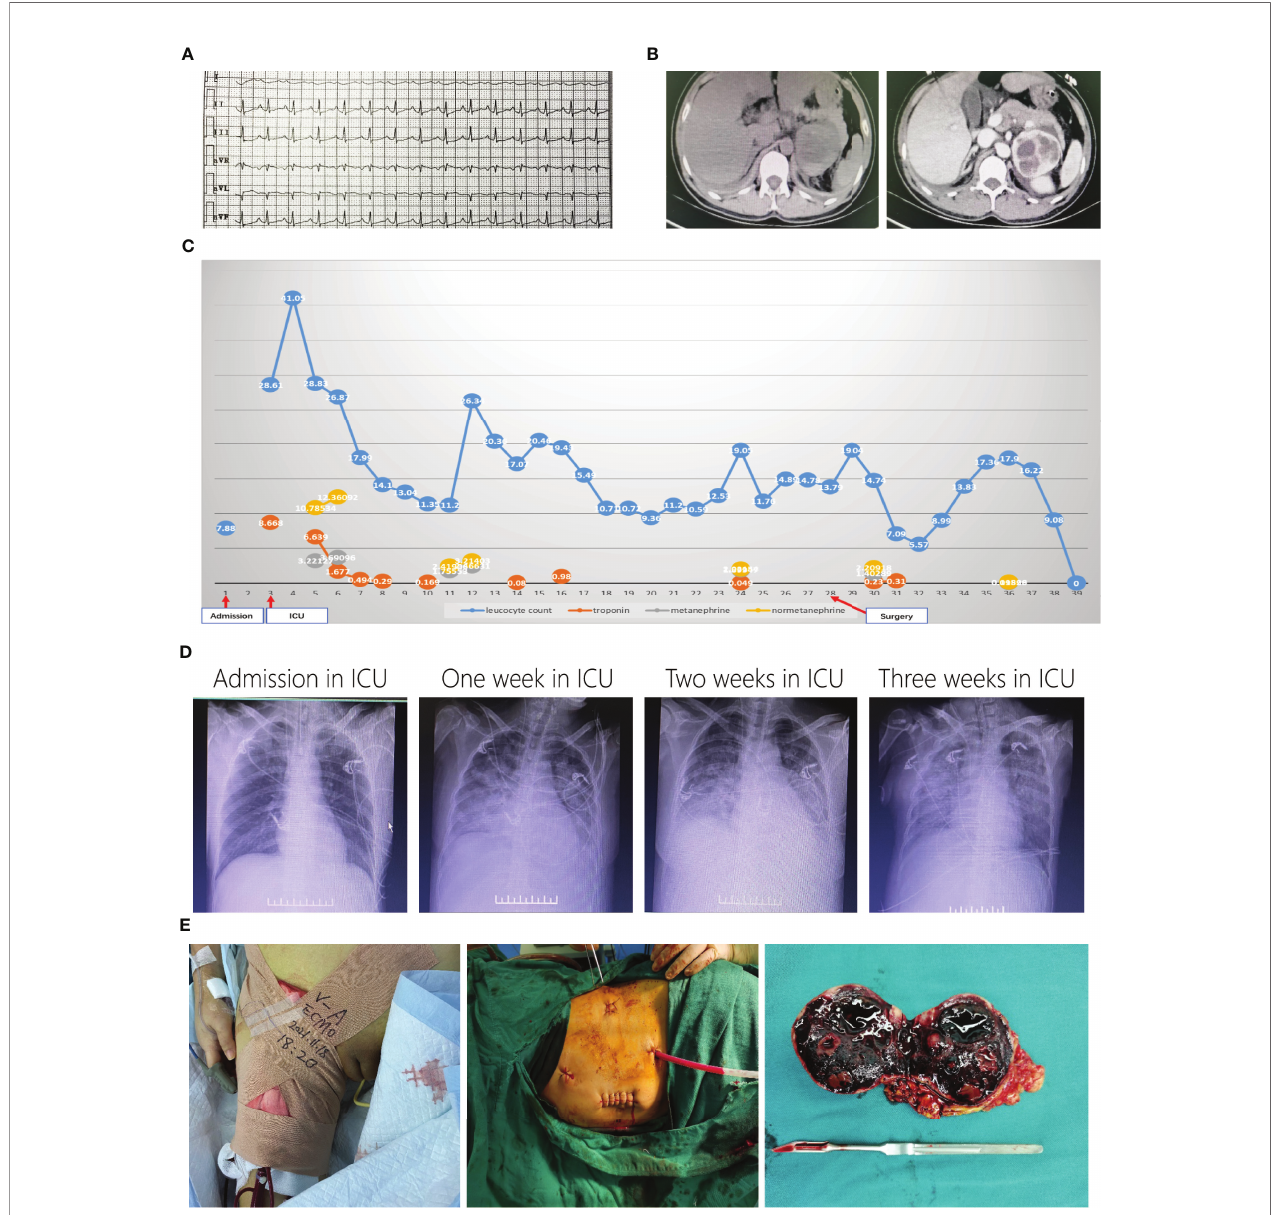
FIGURE 2 | Representative images of patient 2. ECG showed tachycardia when admission in ICU (A) . Enhanced CT showed left right adrenal mass (B) . Curves of leukocyte count, troponin, metanephrine and normetanephrine showed recurrent crisis happened several times (C) . Chest X-ray changes after admission in ICU (D) . Laparoscopic surgery with ECMO support (E)